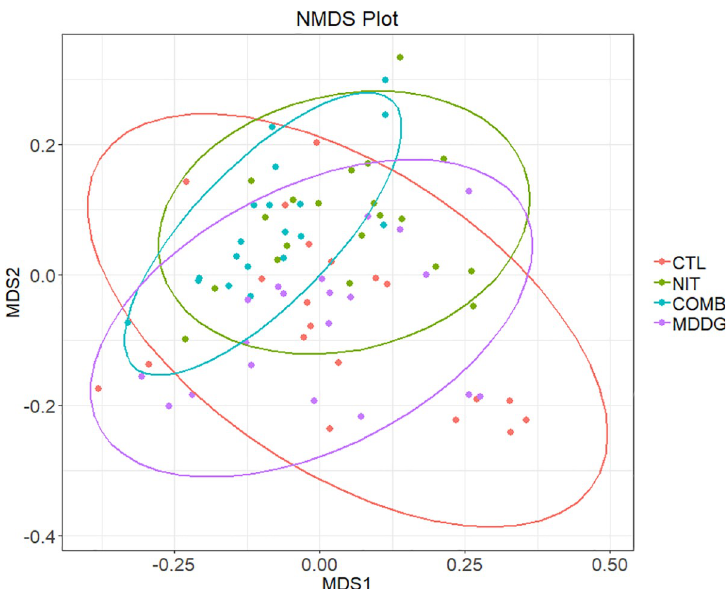
Fig 2. Difference in community structure between dietary treatments using NMDS plot showing the 95% confidence interval ellipse for each dietary treatment.